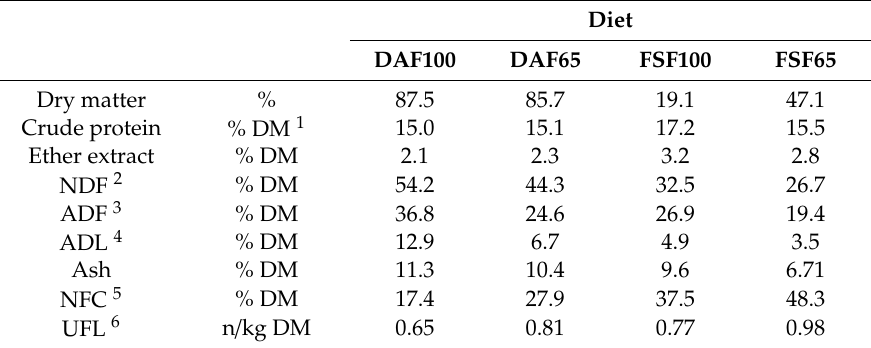
Table 1. Chemical composition of